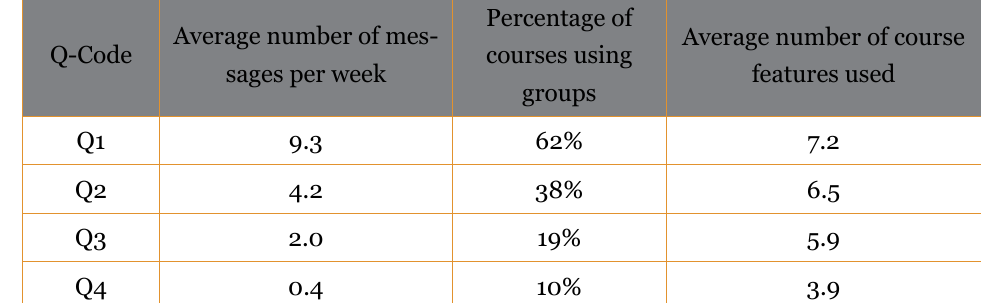
Q-Code Level of Interaction